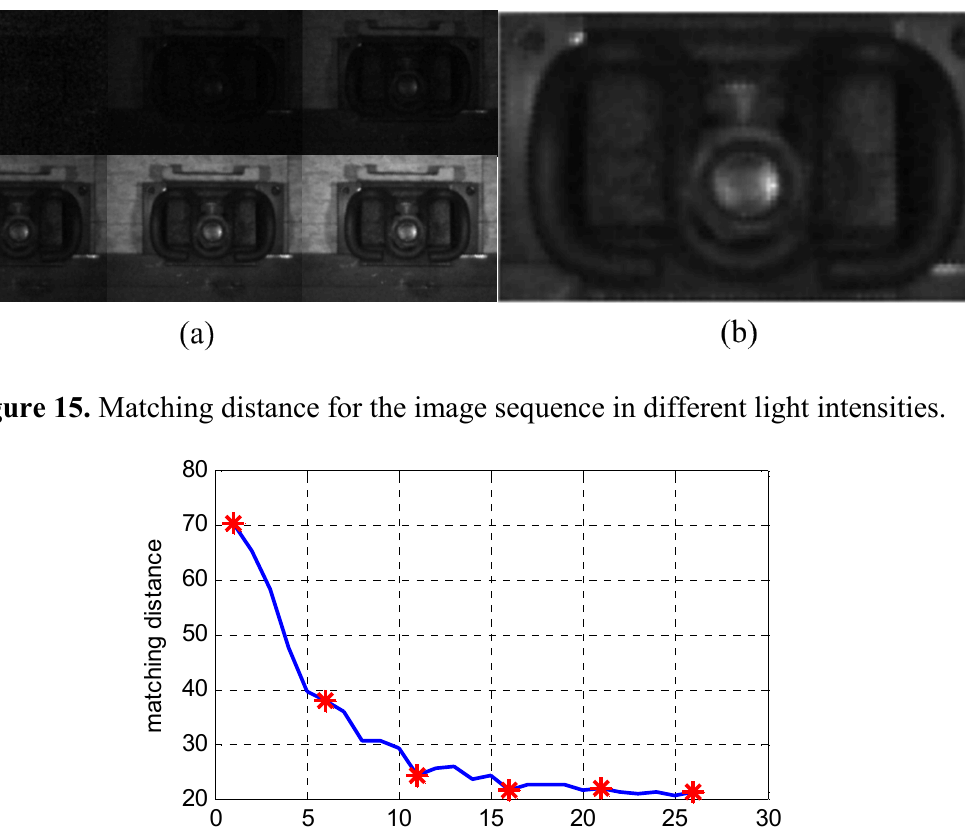
Figure 14. Fastener image in different light intensities and a normal pattern. (a) Fastener image sequence; (b) A fastener image as the pattern